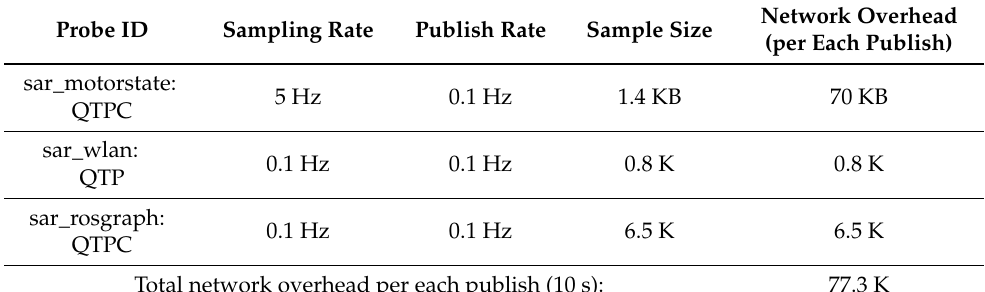
Table 1. Network load introduced by